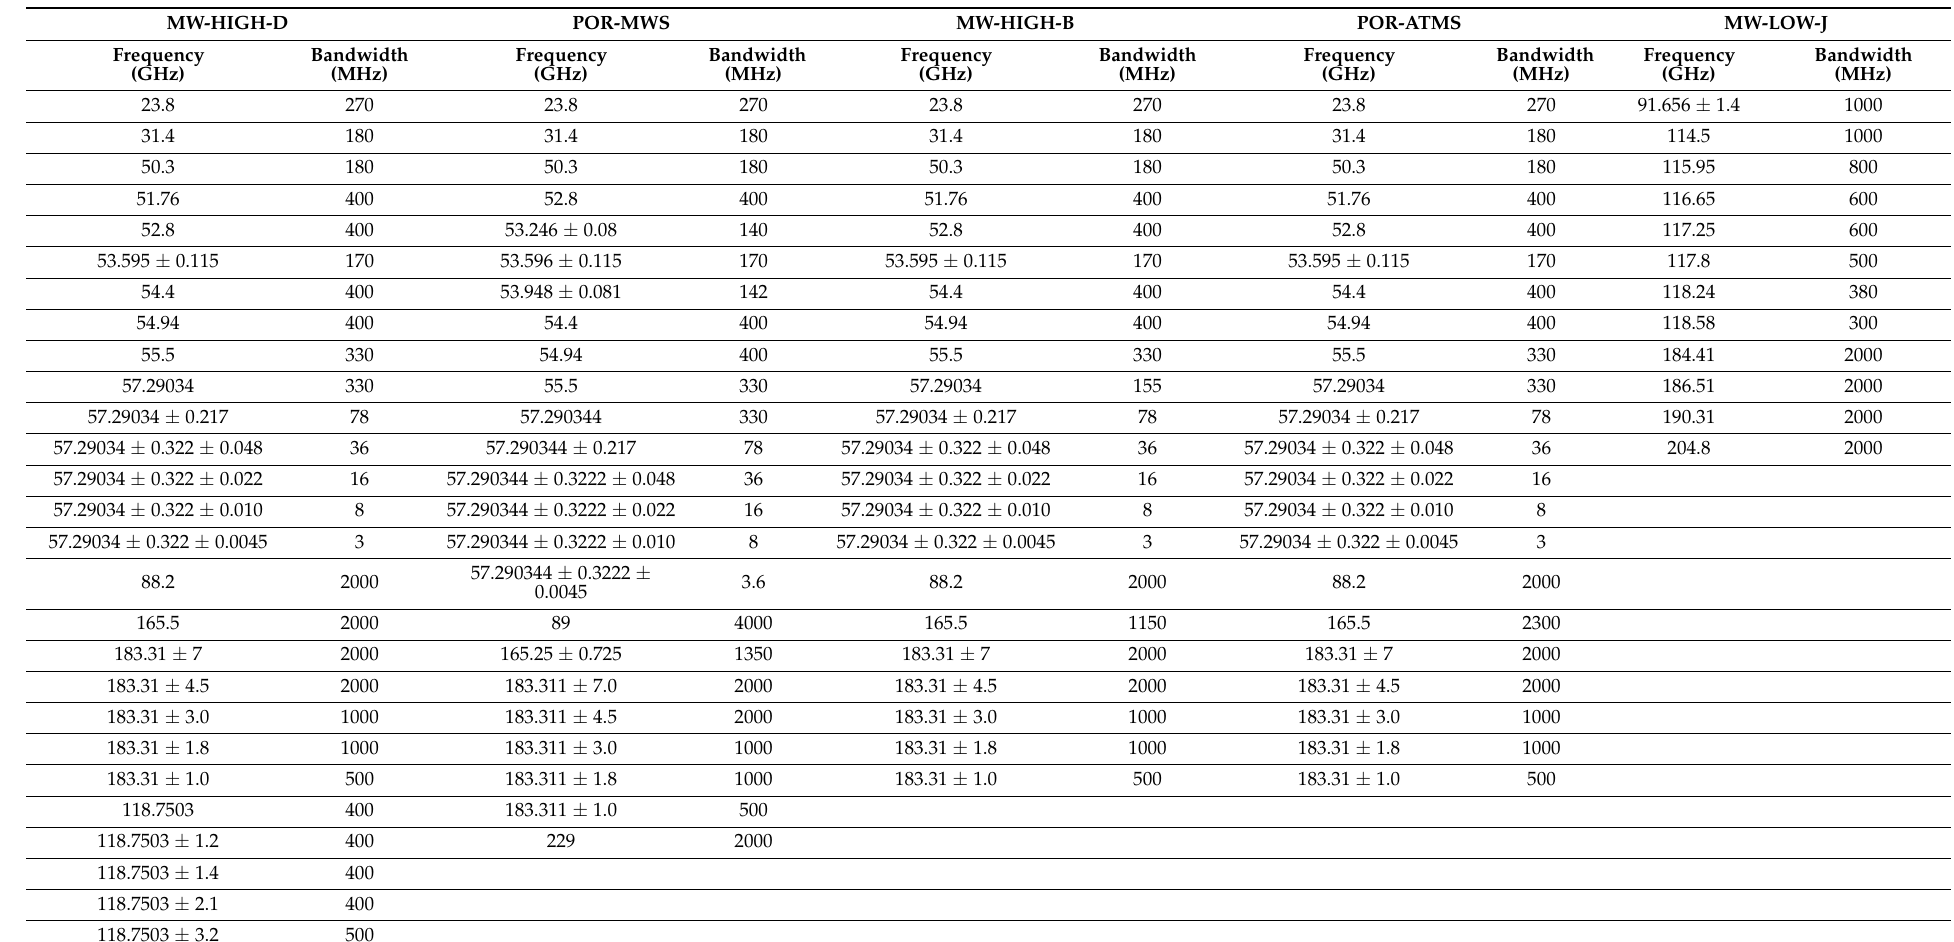
Table 2. Center frequencies and bandwidths of the five microwave sensors